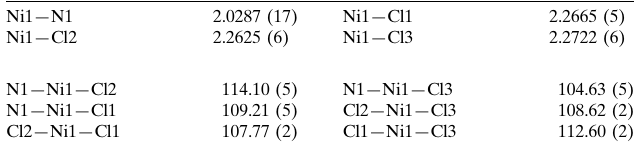
Selected geometric parameters (A˚ , (cid:2) ).